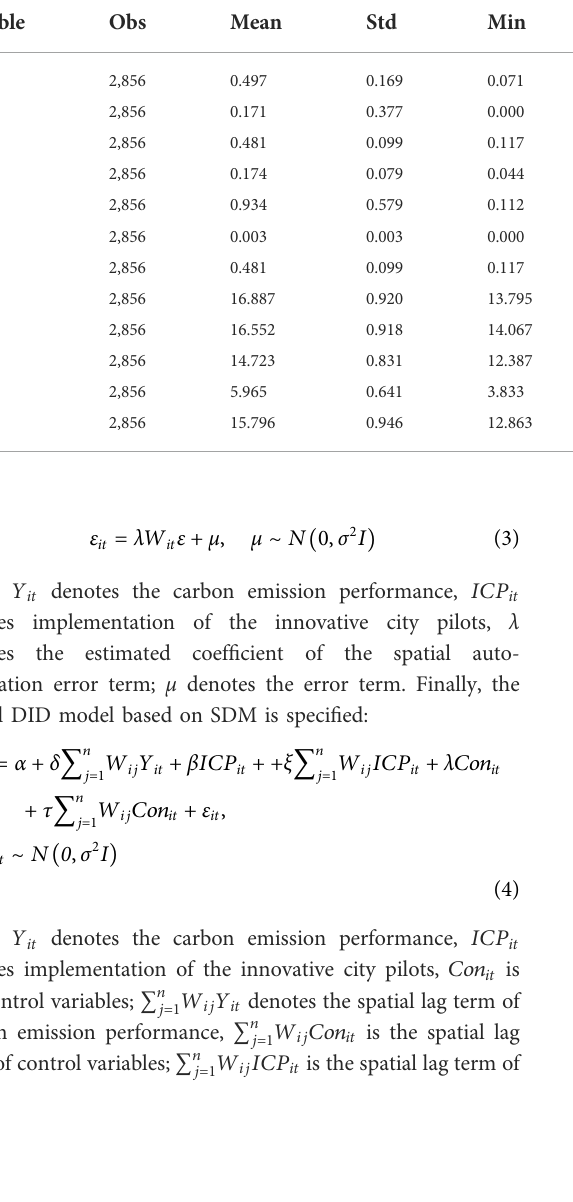
TABLE 2 Descriptive